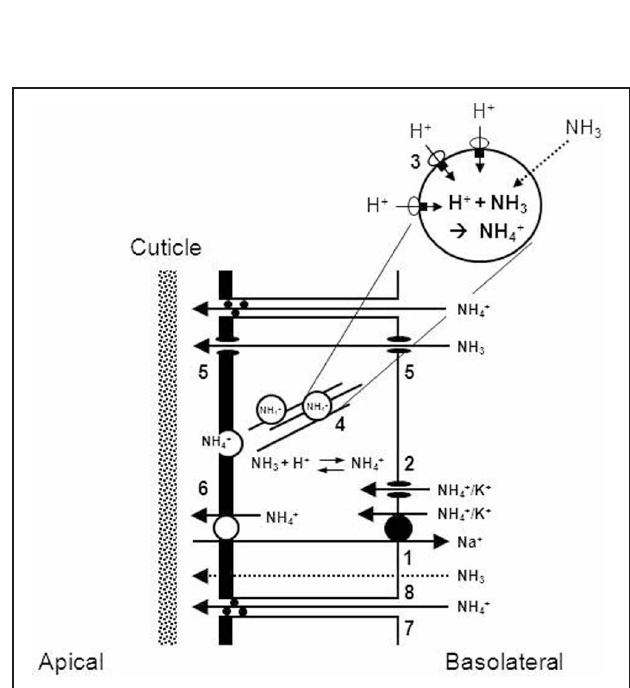
FIGURE 9 | Hypothetical model of branchial ammonia excretion in the gills of the shore crab Carcinus maenas . NH + 4 ions are pumped across the basolateral membrane by Na + /K + -ATPase (1) or traverse the membrane via potassium channels (2). Dissociation of cytosolic NH + 4 to H + and NH 3 is accompanied by diffusion of NH 3 down a partial pressure gradient into vesicles acidified by a H + -ATPase (3). Vesicles loaded with ammonium ions are then transported via the microtubule network (4) to the apical membrane where NH + 4 is released into the subcuticular space by exocytosis. The localization of the Rh-protein (5) cloned from C. maenas gills (RhCM, GenBank Accession number: AF364404) is uncertain. Participation of an apical NHE (6), paracellular diffusion of NH + 4 (7), and non-ionic transcellular diffusion of NH 3 (8) cannot be excluded but are likely low, as shown in a transport kinetic study (Weihrauch et al., 1998). (Modified after Weihrauch et al.,